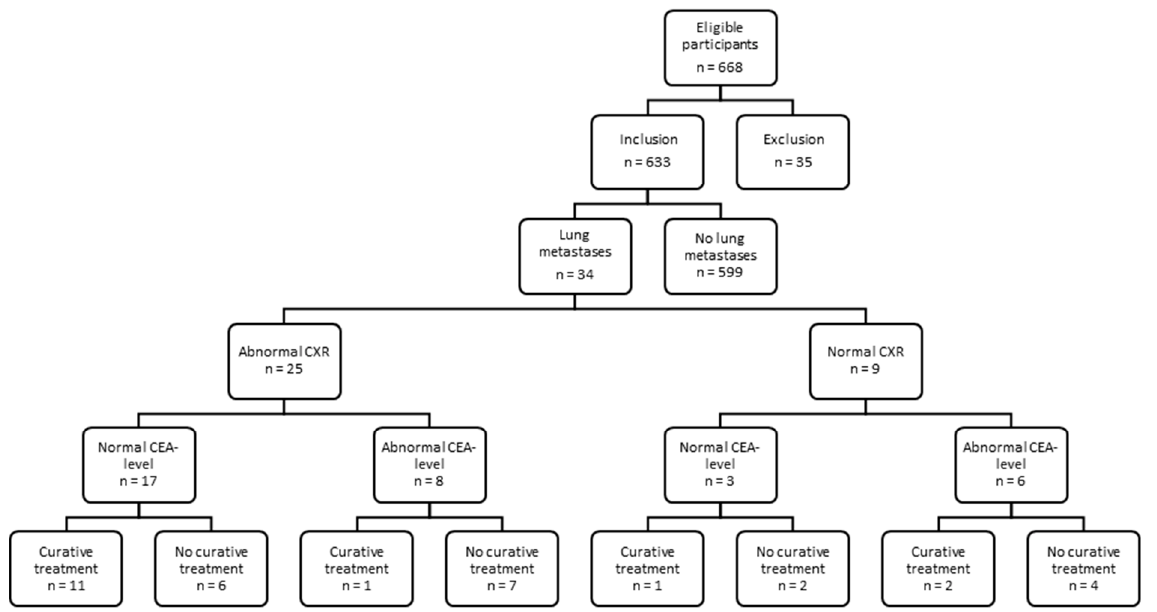
Figure 1. Flow chart of patients in the follow-up after curative treatment for colorectal cancer. Within the group of patients with lung metastases, 21 patients had colon cancer (5% of all colon cancer patients) and 13 patients had rectal cancer (7% of all rectal cancer patients). The timing of the development of lung metastases varied greatly, between 6 and 63 months after curative resection (median 20 months). In colon cancer, three (14%) patients developed lung metastases in the first year and, in rectal cancer, two (7.7%) patients. Most metastases were found in the second and third year after curative resection (Figure 2).